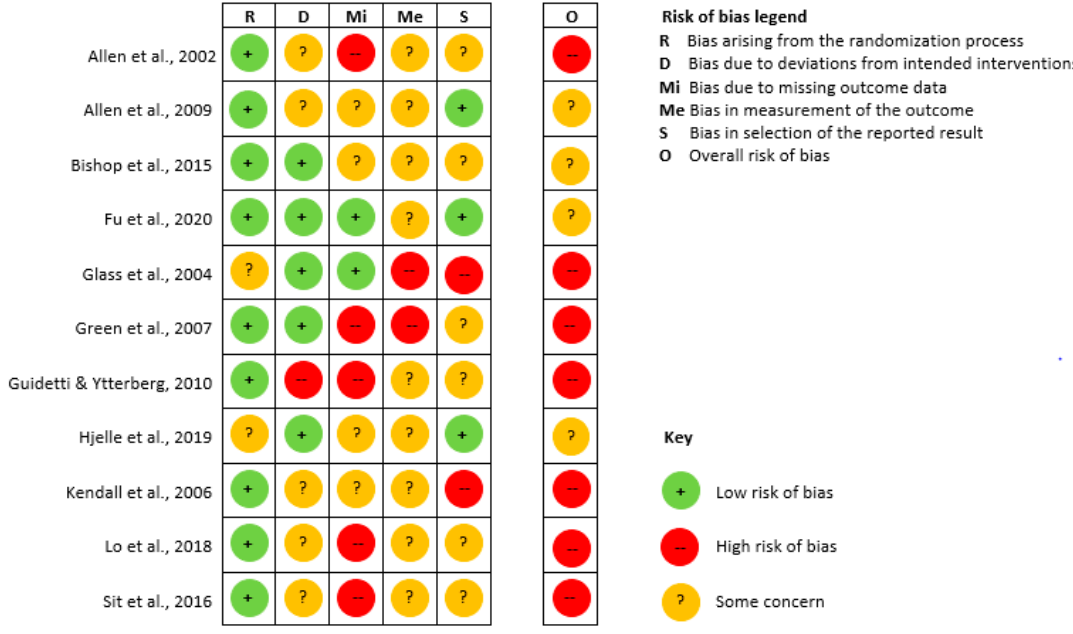
Figure 2. Risk of